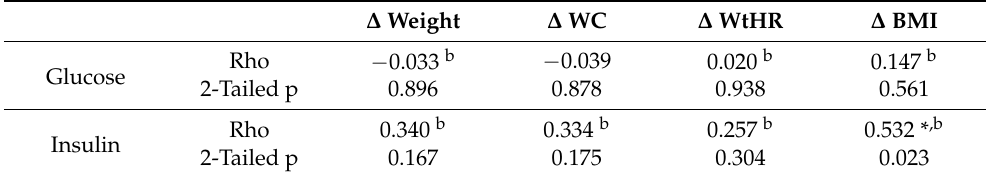
Table 5. Correlations between the differences of each anthropometric variable and the blood bio- chemical parameters between T1 and T0 for the sertraline